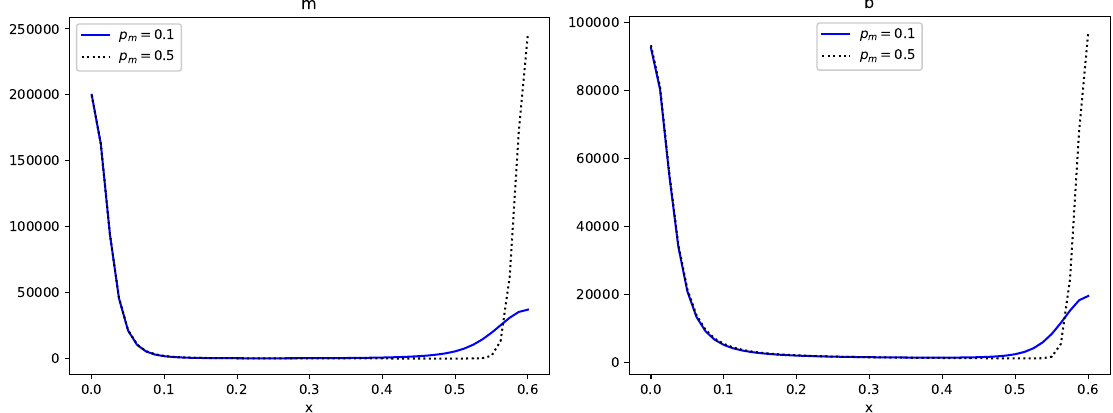
Figure 5. Concentration of platelets along the spatial domain at the final time for the case of p m = 0.1 (blue) and p m = 0.5 (black).